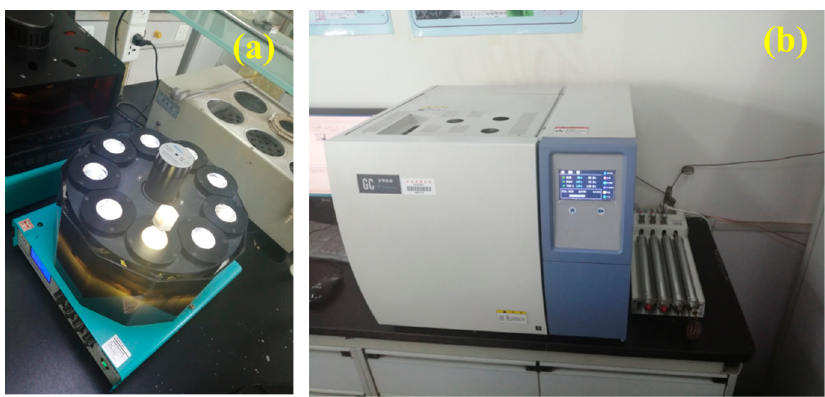
Figure 10. ( a ) The multichannel; ( b ) gas chromatograph